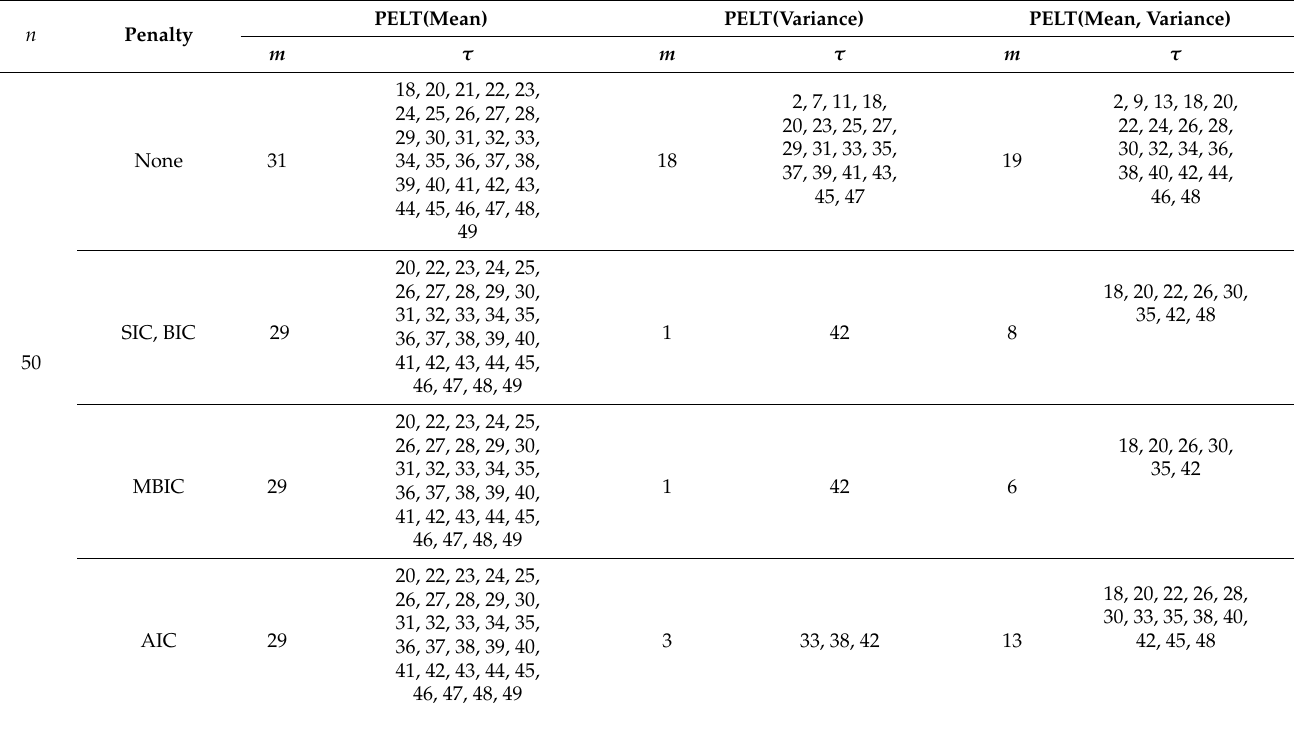
Table A13. PELT Algorithm Result for Poland’s COVID-19 Daily